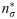
Rank distribution of the (decimal) logarithm of the stationary population densities nσ* for different values of the adaptation velocity d (see Figure J in S1 Text for more information on the parameters used).The lines represent the average value over 100 iterations, while the opaque bands outline the standard error of the mean. For d = 0 (blue line) the rank distribution is very steep and only the first few species have a population density over 1 cell/mL (corresponding to lognσ*=0), while as d increases the distribution becomes more even. Setting lognσ*=0 as the extinction threshold, approximately two thirds of the species in the system go extinct with d = 10−7 (yellow line), while all of them survive with d = 10−5.